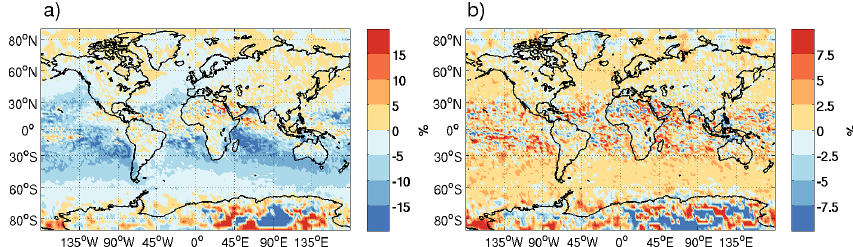
Figure 14. Relative difference in 5-year-mean cloud droplet number burden between (a) ossa-ref and ctrl (range from − 78 to 150%) and (b) ossa-ref and ossa-salt (range from − 66 to 102%).